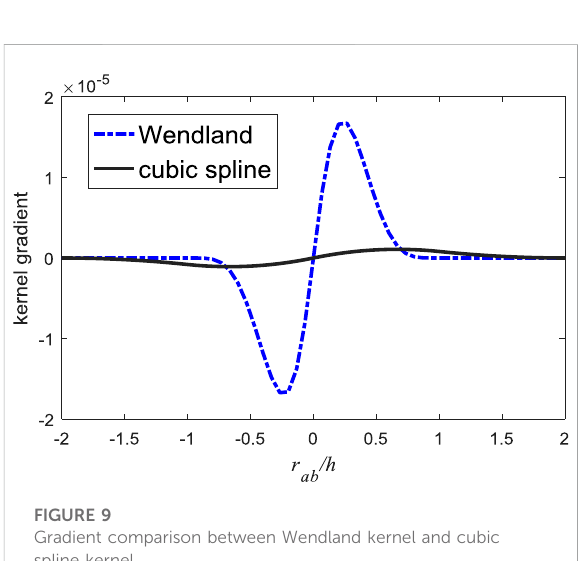
FIGURE 10 Simulation results for one rotation by Lind ’ s PST with Wendland kernel without